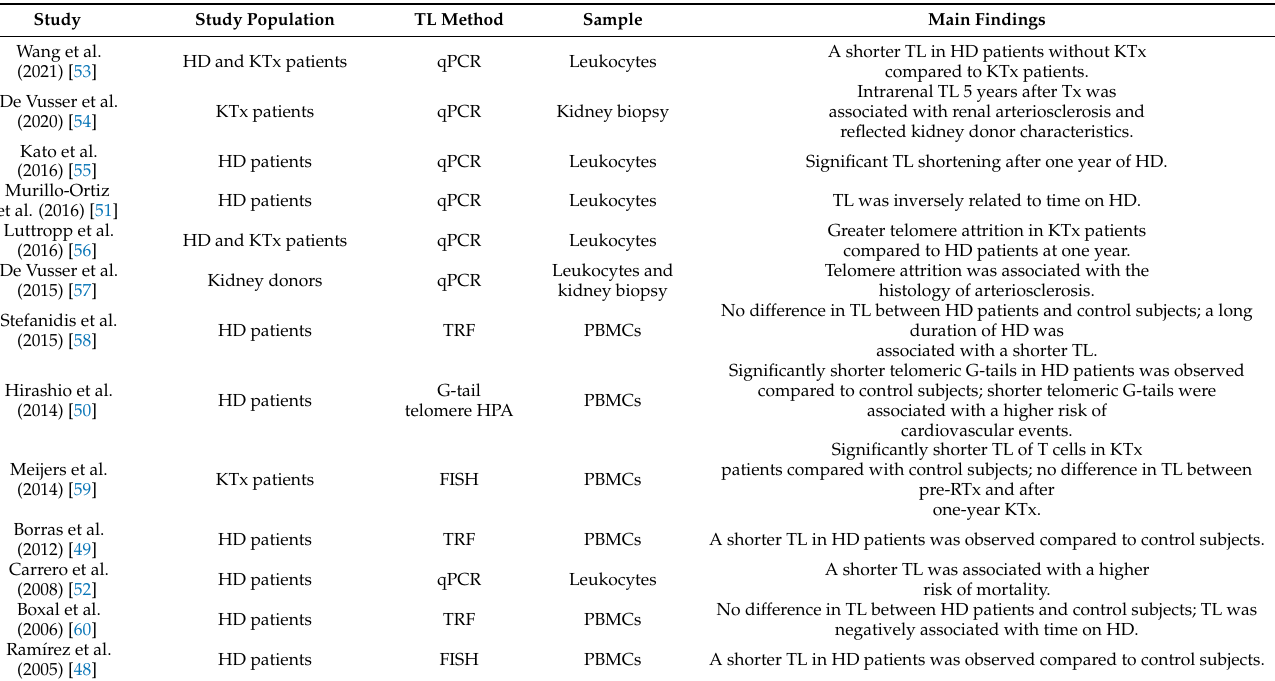
Table 2. Studies on telomere length in patients on kidney replacement